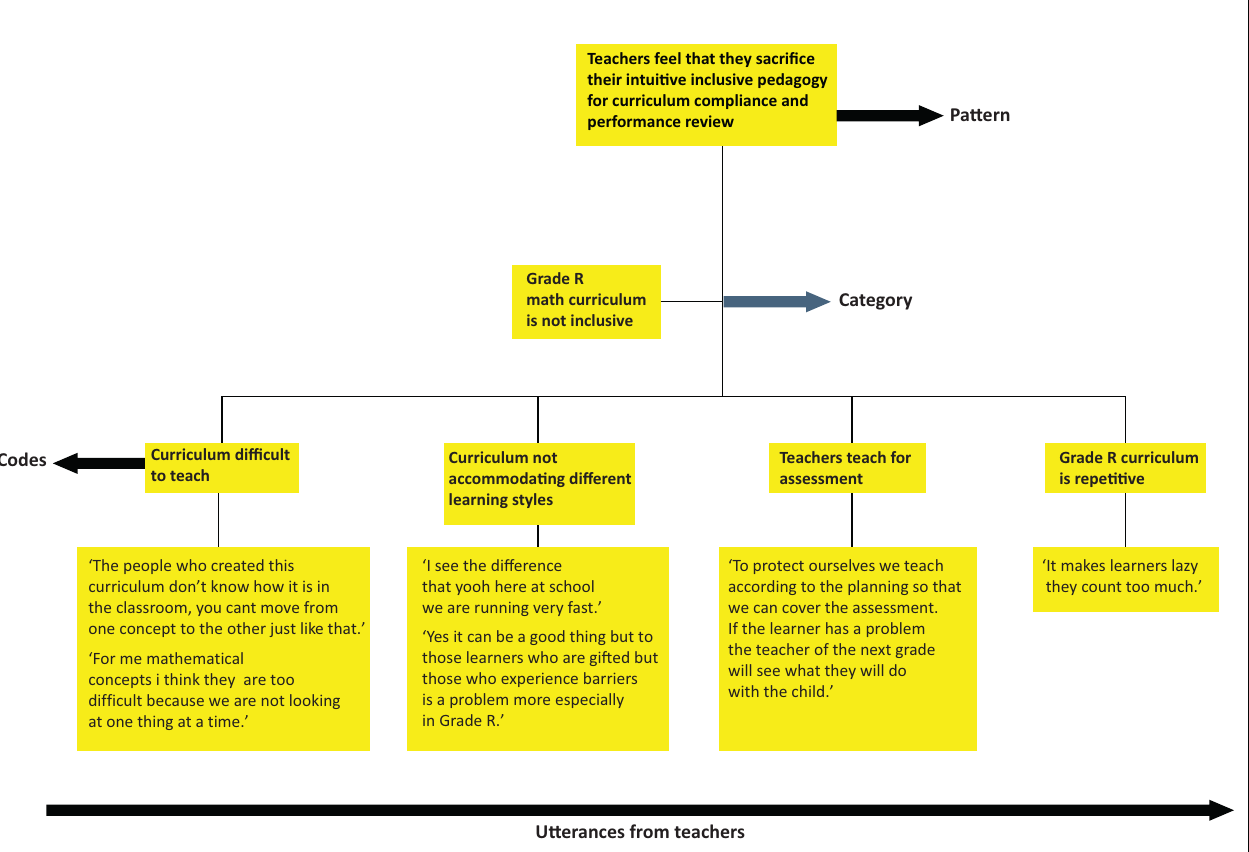
FIGURE 4: Example of a few codes that were grouped in one category that formed part of the final pattern of the